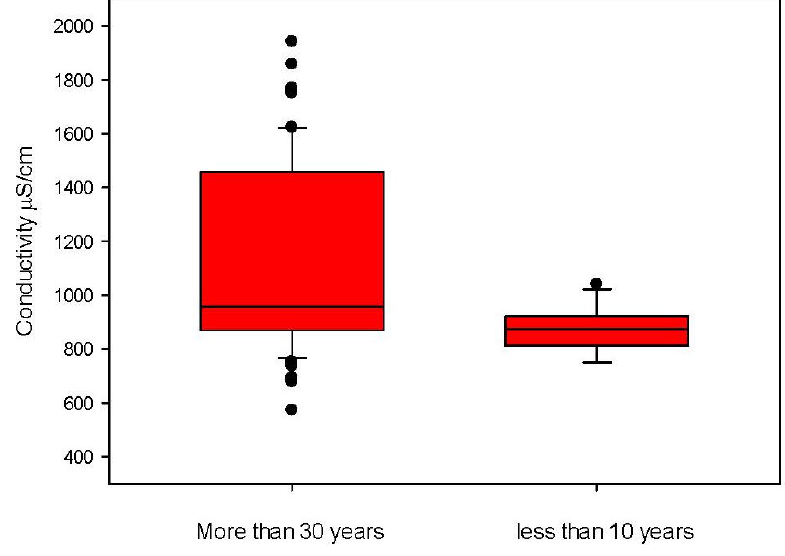
Figure 3. Experimentally determined conductivities in vessels aged more than thirty years and less than ten years. The distribution is shown by a vertical box plot as the median (lines), 25th and 75th percentiles (boxes) and 90th and 10th percentiles (whiskers). Circles mark the outliers.